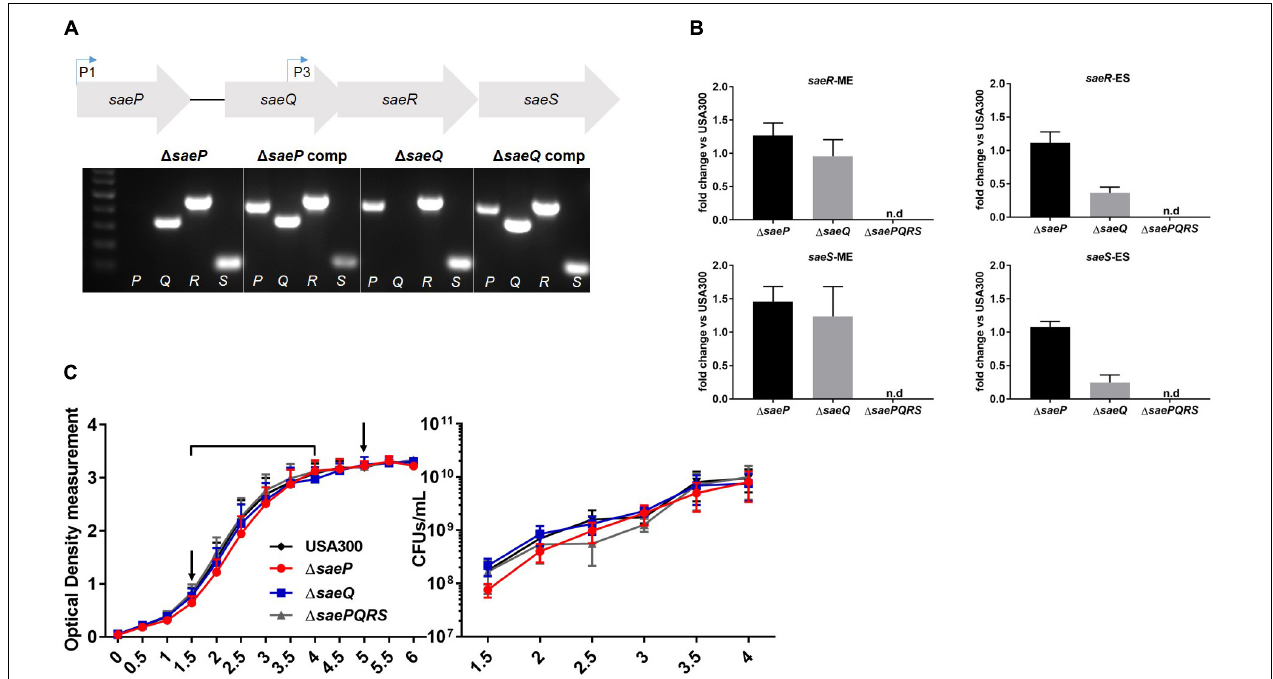
FIGURE 1 | Generation of an isogenic saeQ mutant. (A) (Above) Schematic of the four genes of the sae locus. Bent arrows indicate transcriptional start sites described in Novick and Jiang (2003), Steinhuber et al. (2003), and Jeong et al. (2011). (Below) Results of agarose gel electrophoresis showing USA300 mutants lacking saeP (from Kavanaugh et al., 2019), saeQ, and respective complemented strains. Letters at the bottom of the gel indicate the sae gene targeted by PCR analysis. Primer sequences are included in Table 1 . (B) TaqMan R (cid:13) RT-PCR analysis of saeS and saeR transcript levels in USA300 (cid:49) saeP and USA300 (cid:49) saeQ relative to USA300 at mid-exponential phase (ME) and early stationary phase (ES). Transcript levels in samples were analyzed in triplicate and results are from two independent experiments. (C) In vitro growth of USA300, USA300 (cid:49) saeP, USA300 (cid:49) saeQ , and USA300 (cid:49) saePQRS (Flack et al., 2014) measured by optical density at 600 nm (OD 600 ) (left) and colony forming units (CFUs) (right). Timepoints are indicated by the bracket on the OD 600 plot. Arrows indicate time points for RNA harvest (used in B ). Data are presented as the mean ± SEM of seven independent experiments. n.d., not